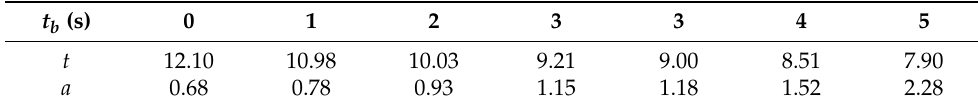
Table 3. The values of t and a when t begin take different values.